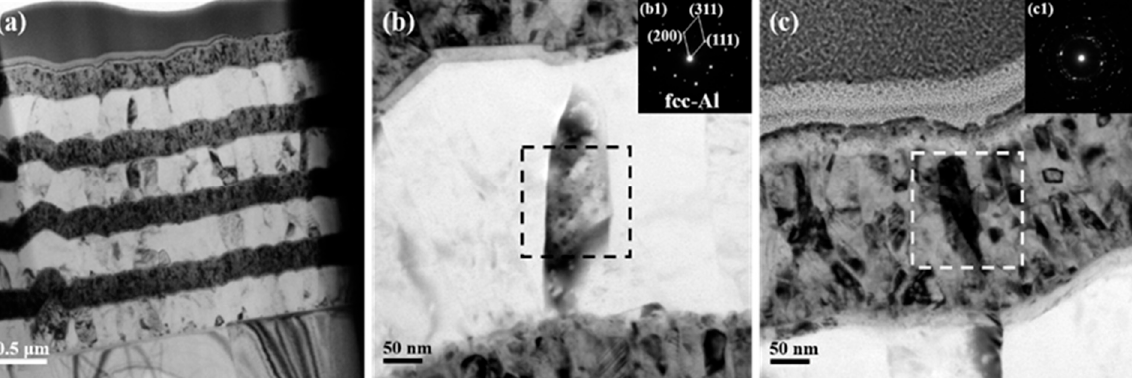
Figure 2. TEM images together with selected area electron diffraction patterns of the as ‐ deposited ATNT foil: ( a ) the whole morphology; ( b ) the Al layer in the middle region; ( c ) the Ni layer in the top region.